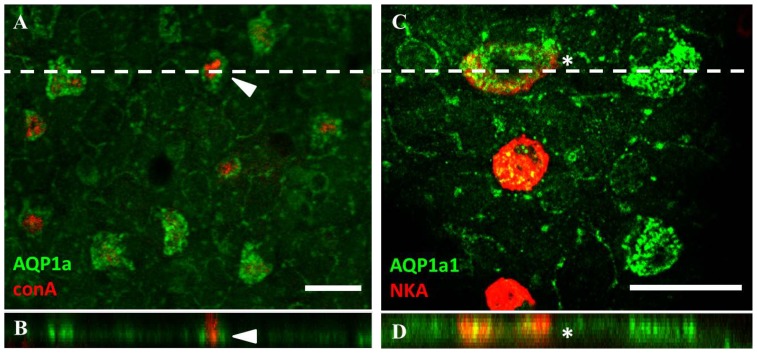
Aquaporin-1a1 is expressed predominantly on the basolateral membrane of ionocytes.Fluorescent immunohistochemistry and z-stack analysis with confocal microscopy revealed that (A and B) the expression of aquaporin-1a1 (AQP1a1; green) does not overlap with concanavalin-A staining (arrow; red). (C and D) However, AQP1a1 expression is found to co-localize with Na+/K+-ATPase (NKA; red) staining (cell labelled with an asterisk). Dashed lines in A and C indicate the position for z-stack images in B and D, respectively. Scale bar  = 20 μm.